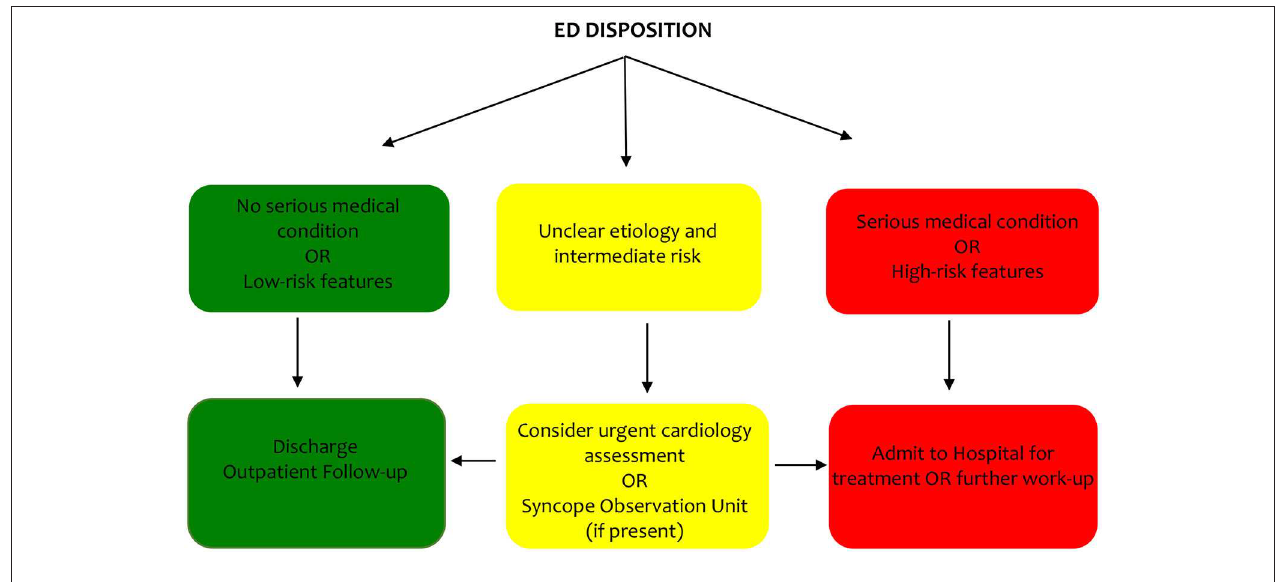
FIGURE 1 | Proposed disposition strategy from